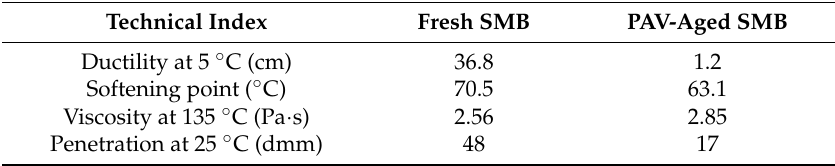
Table 1. Primary physical properties of styrene–butadiene copolymer modified bitumen (SMB) before and after pressure aging vessel (PAV)